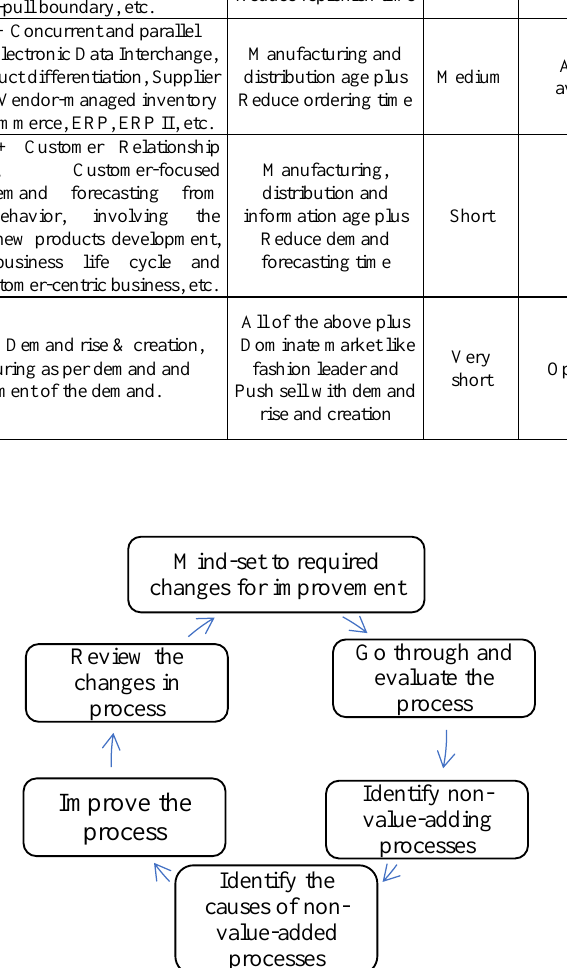
Figure 1. Methodology for time-based process improvement (Harrison and Hoek 2011)